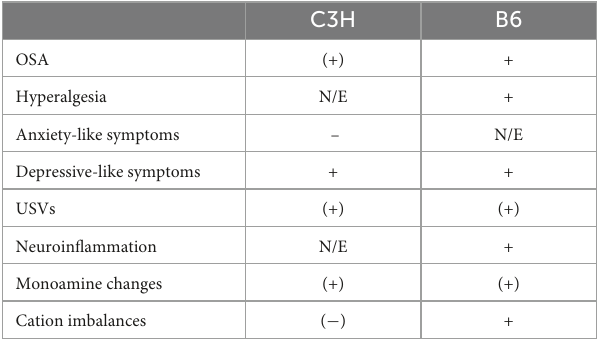
TABLE 1 Summary of behavioral and biochemical effects in C3H and B6 mice.